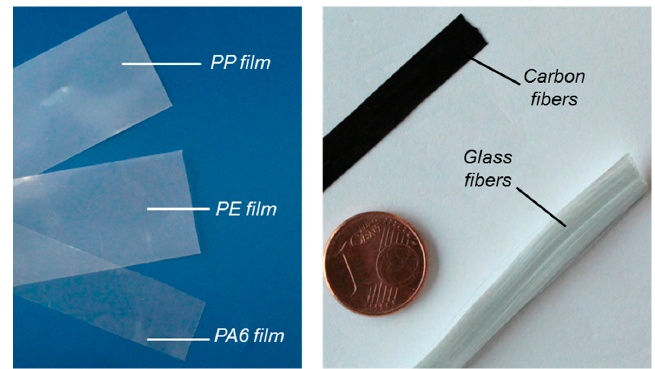
Figure 4. Overview of the polymer foils and fiber materials used in this paper.